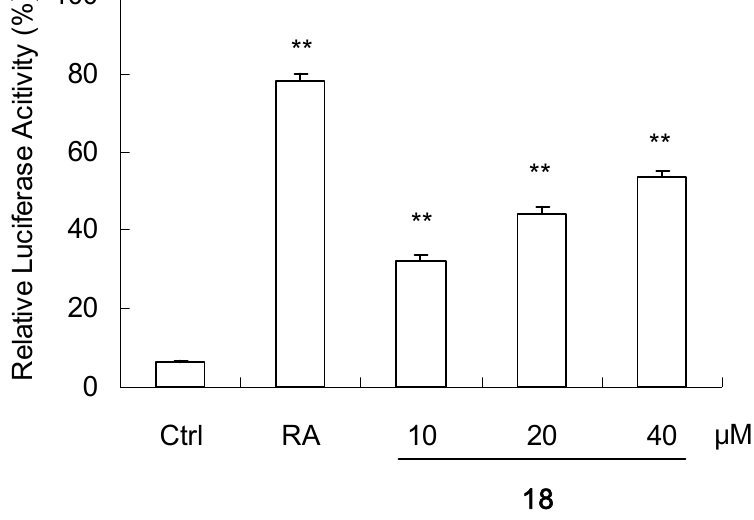
Figure 3. Promoting effect of compound 18 on reporter transcription activities of RXR α with